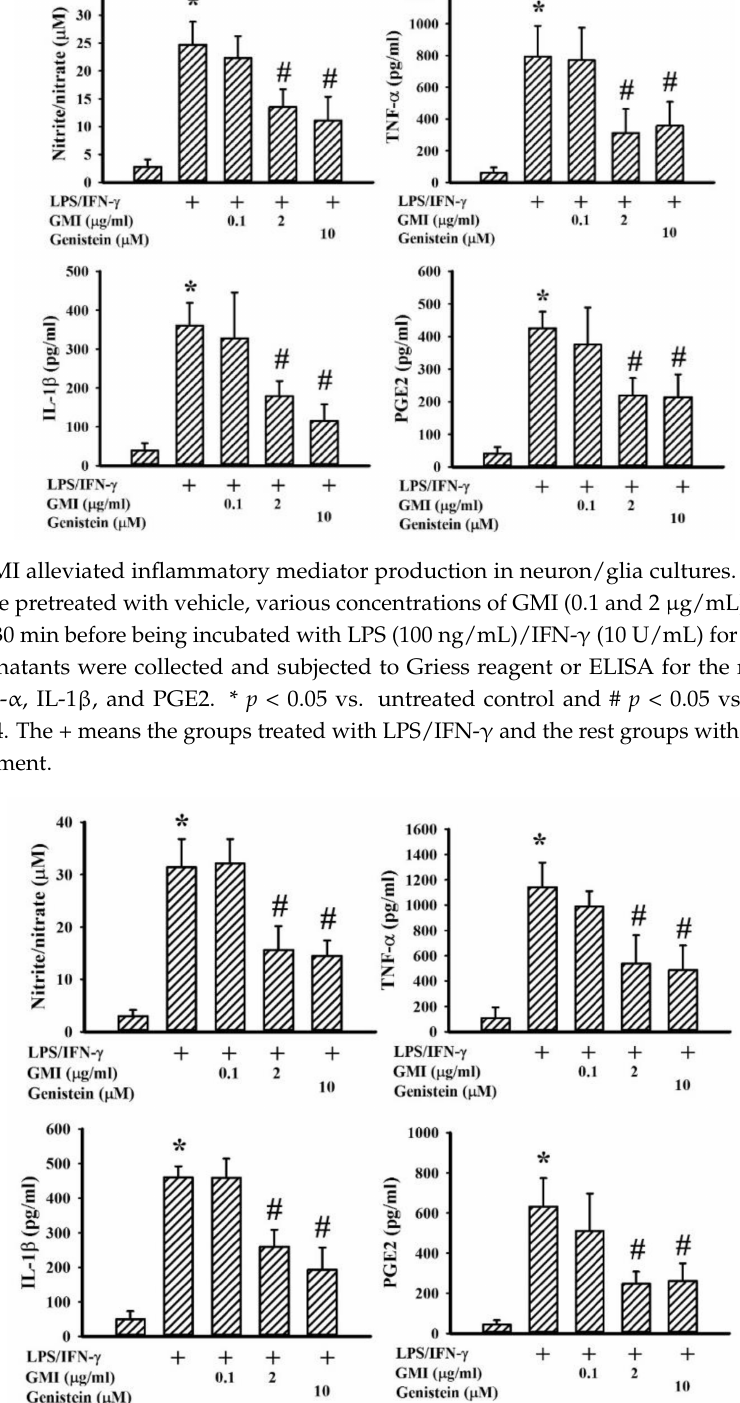
Figure 4. GMI alleviated inflammatory mediator production in mixed glia cultures. Mixed glia cultures were pretreated with vehicle, various concentrations of GMI (0.1 and 2 µ g/mL), or genistein (10 µ M) for 30 min before being incubated with LPS (100 ng/mL)/IFN- γ (10 U/mL) for an additional 24 h. Supernatants were collected and subjected to Griess reagent or ELISA for the measurement of Nitric Oxide (NO), TNF- α , IL-1 β , and PGE2. * p < 0.05 vs. untreated control and # p < 0.05 vs. LPS/IFN- γ control, n = 4. The + means the groups treated with LPS/IFN- γ and the rest groups without + indicate vehicle